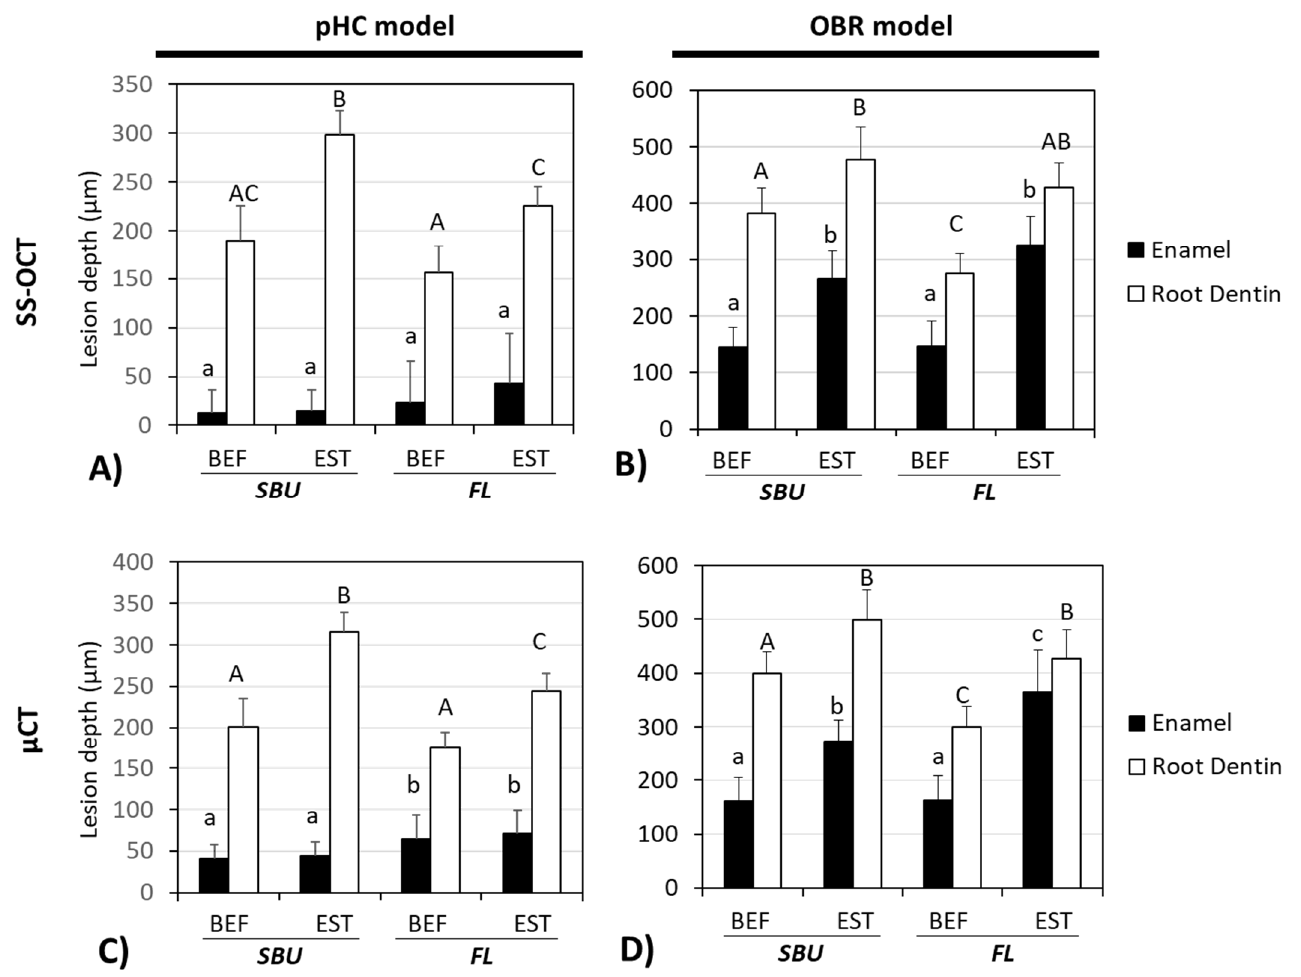
Figure 5. SS-OCT and µ CT assessments of lesion depths of pHC model ( A , C ) and OBR model ( B , D ). Groups labeled with different letter superscripts showed significant differences ( p < 0.05). BEF—Beautifil II ® composite, EST—Estelite ® composite, SBU—Single Bond Universial ® adhesive, FL—FL Bond II ® adhesive. pHC—pH cycling model, OBR—oral biofilm reactor model.